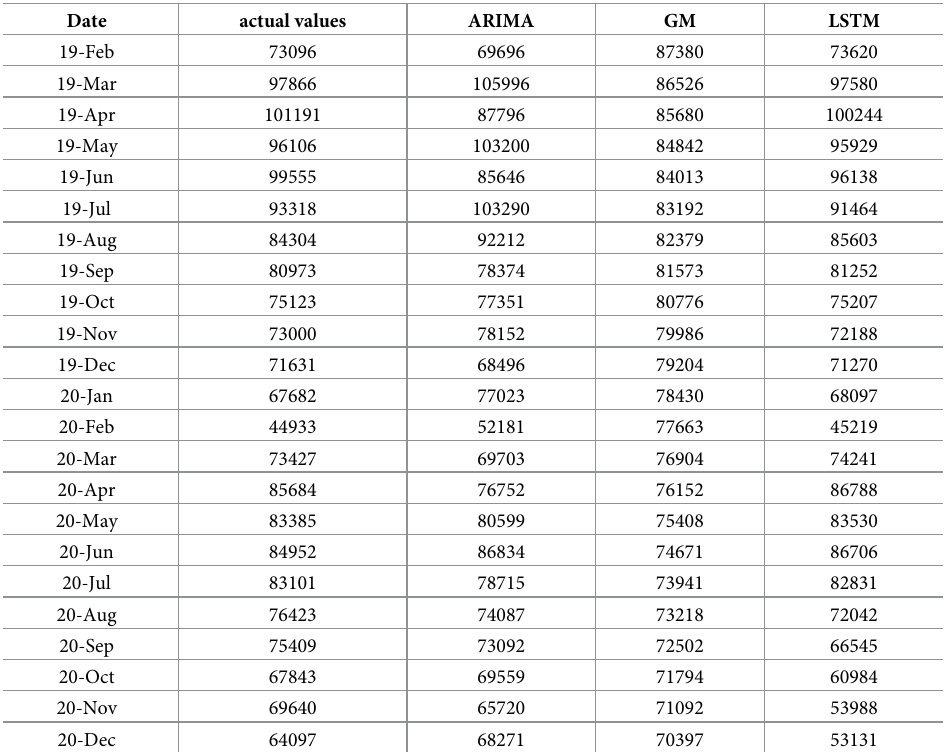
Table 4. The actual values and the prediction results of the three